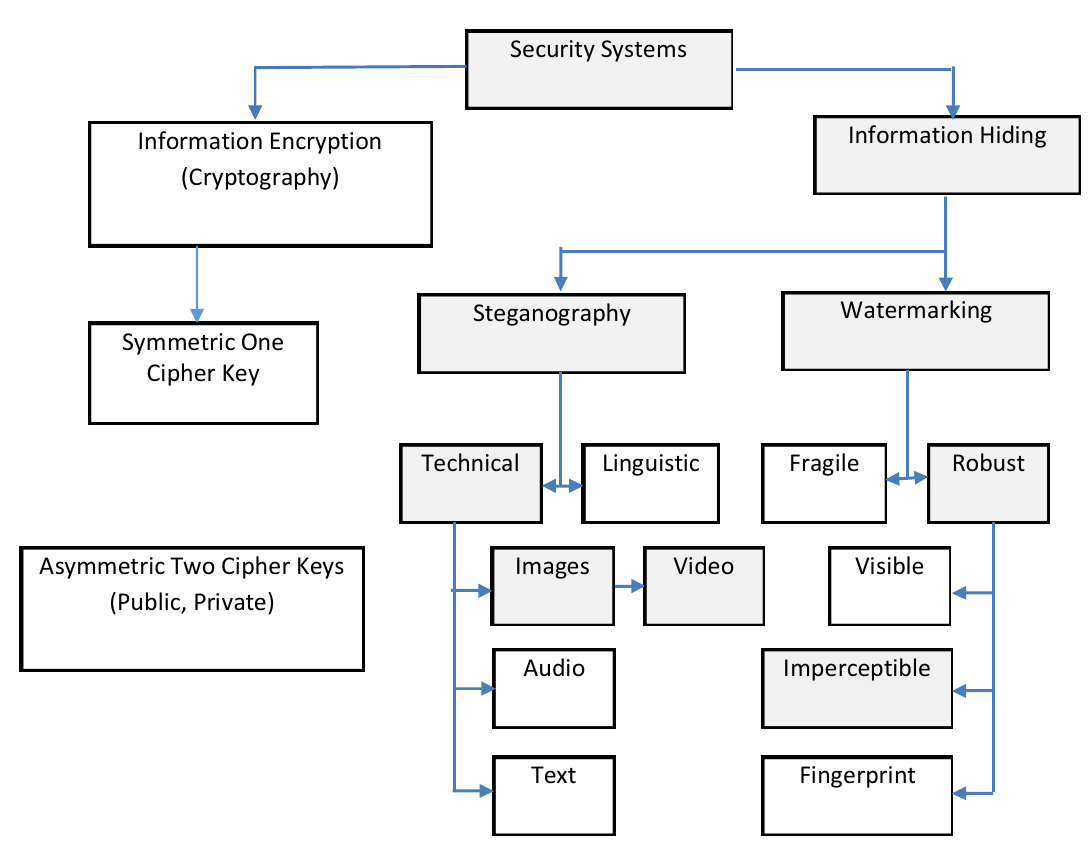
Fig. 1. Information security